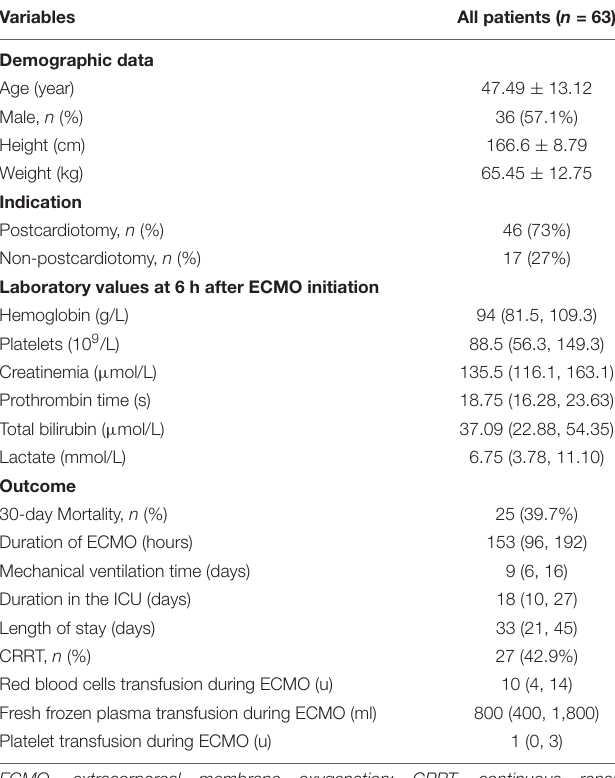
TABLE 1 | Patient characteristics ( n =